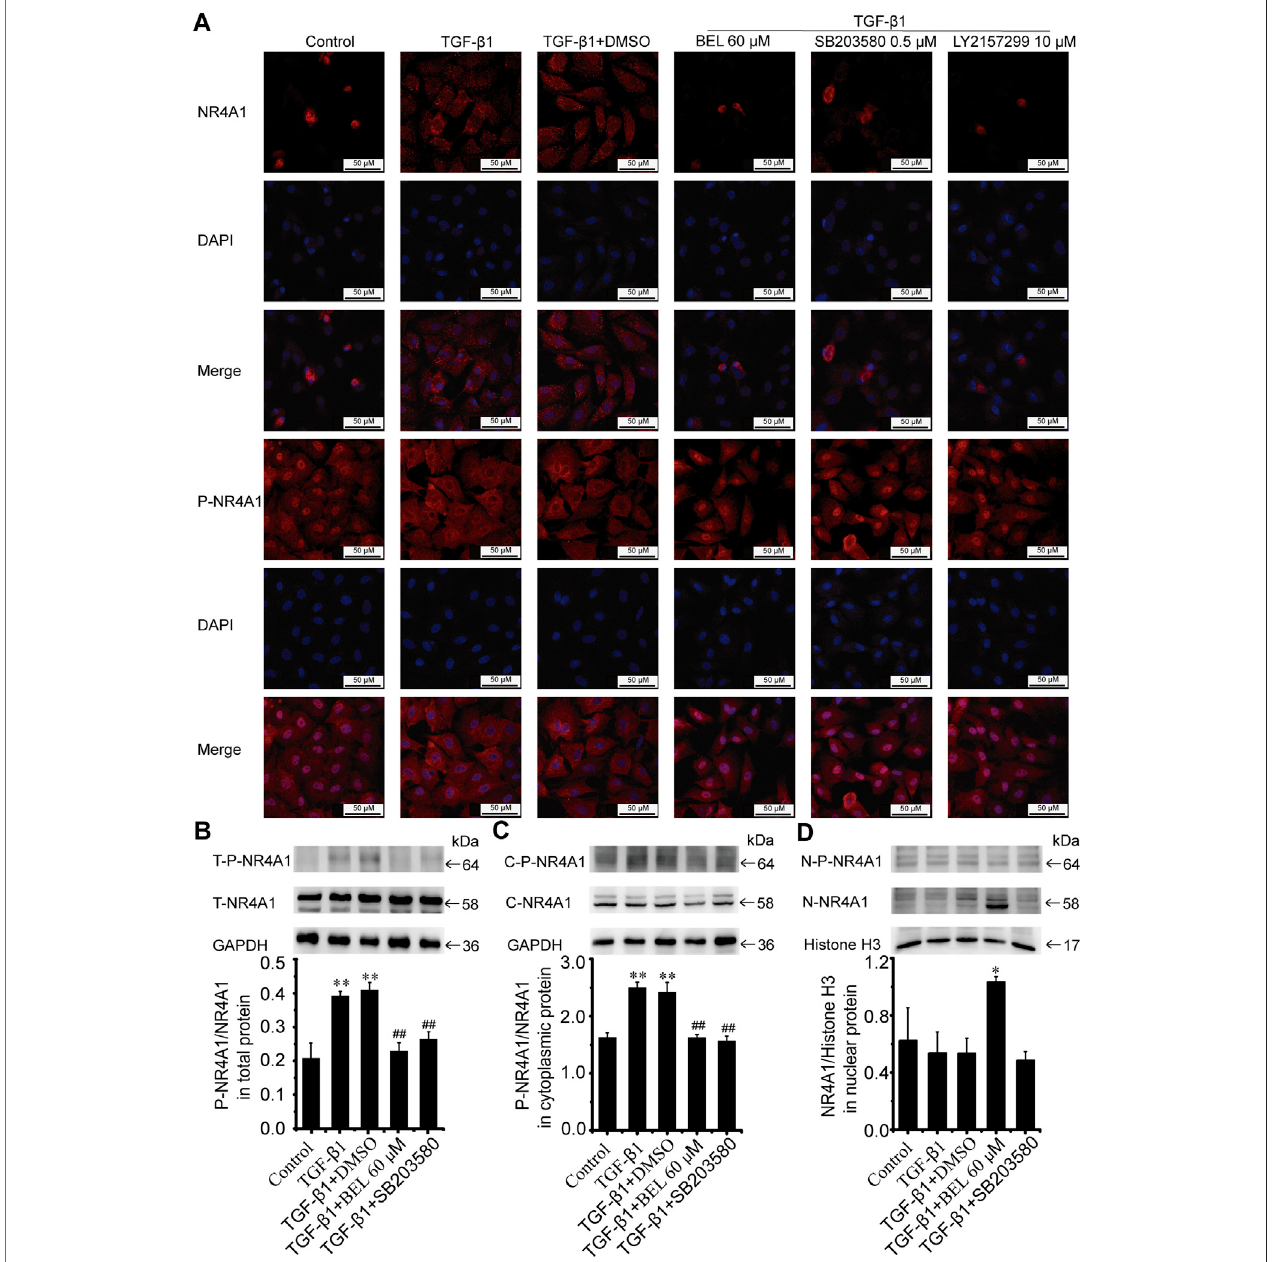
FIGURE 11 | BEL impedes NR4A1 from the nucleus to cytoplasmic localization (A) Effects of BEL, SB203580 and LY2157299 on the expression of NR4A1 and P-NR4A1 inducedbyTGF- β 1using immuno fl uorescence staining.Cell nucleiwascounterstained inblue withDAPI (B) ExpressionofNR4A1 and thelevels ofP-NR4A1 in total protein (T-NR4A1, T-P-NR4A1) by western blotting. Bar graphs show fold changes of P-NR4A1/NR4A1 ( n (cid:2) 3) (C) Expression of NR4A1 and the levels of P-NR4A1incytoplasmicprotein(C-NR4A1,C-P-NR4A1)bywesternblotting.BargraphsshowfoldchangesofP-NR4A1/NR4A1( n (cid:2) 3) (D) ExpressionofNR4A1 and the levels of P-NR4A1 in nuclear protein (N-NR4A1, N-P-NR4A1) by western blotting. Bar graphs show fold changes of NR4A1/H3 ( n (cid:2) 3). Data were shown as mean ± SEM. ** p < 0.01 vs. control, # p < 0.05 vs. TGF- β 1, ## p < 0.01 vs. TGF- β 1.